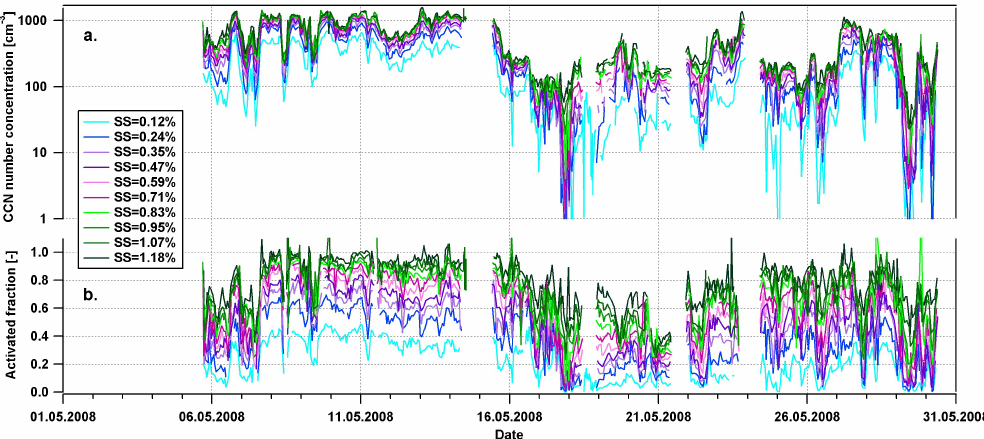
Fig. 1. Time series of (a) CCN number concentration (note logarithmic ordinate scale) and (b) activated fraction (#CCN /N 12 − 570 ). The different colours represent the different supersaturations ( SS ).